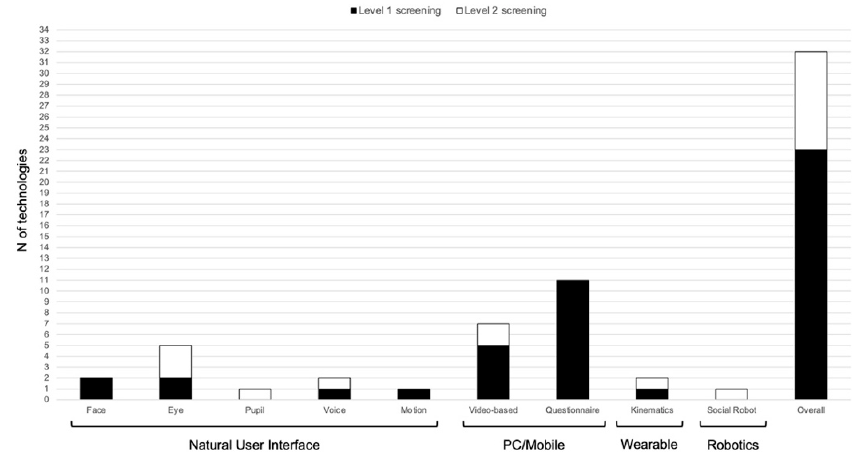
Figure 2. Frequency of technologies used in the papers included grouped according to interface category.